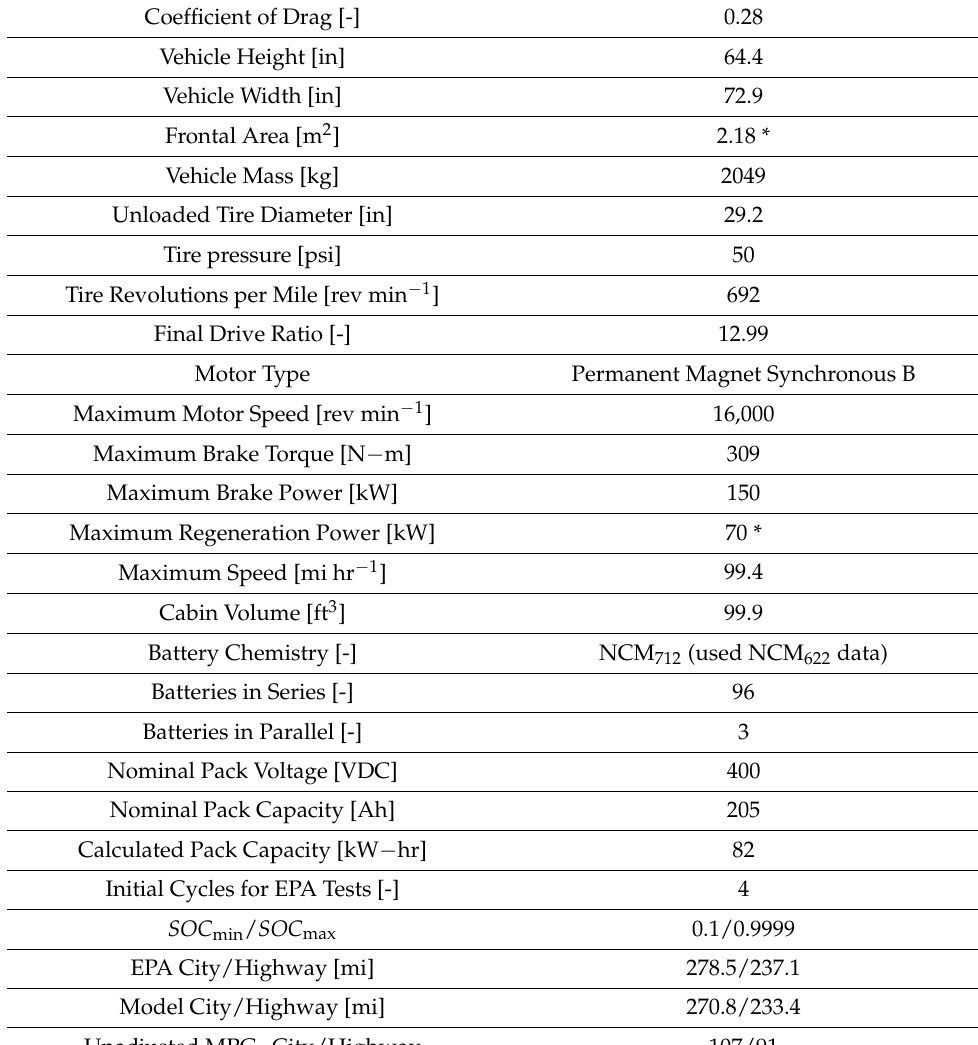
Table A2. Parameters for the 2021 VW